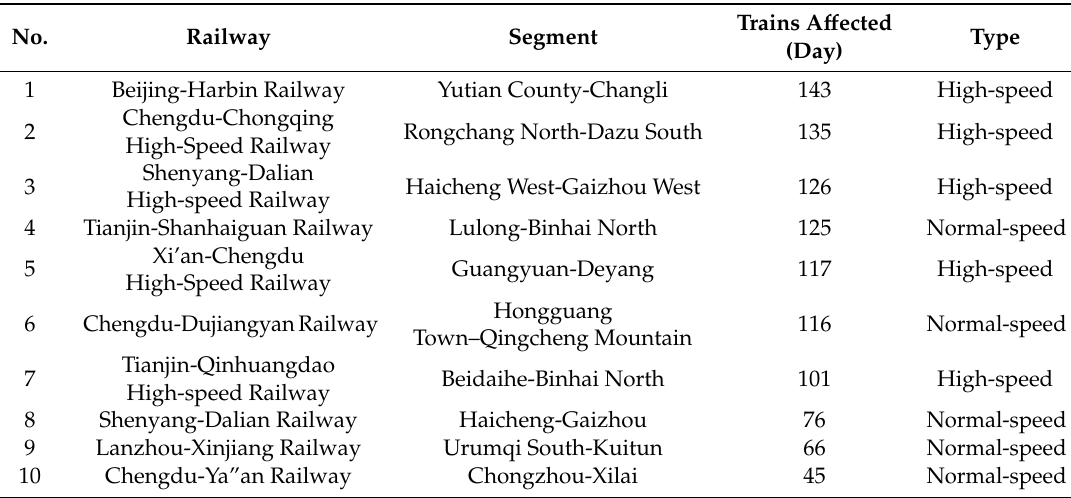
Figure 10. Railway lines under impacts of earthquakes within the four regions. Table 4. Number of trains and railroad sections under impacts of earthquake disasters within the four